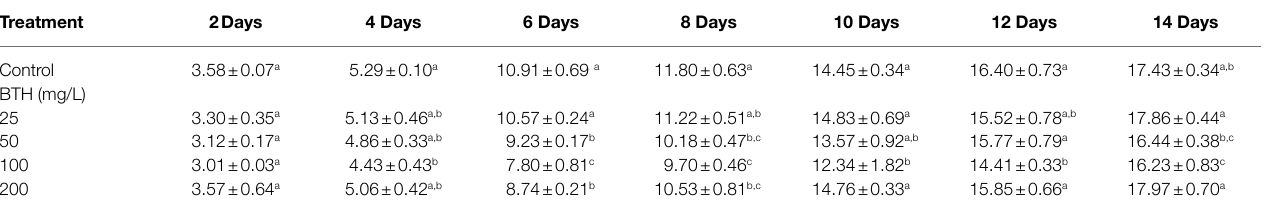
TABLE 1 | Effects of BTH treatment at different concentrations on the weight loss in R. roxburghii fruit.